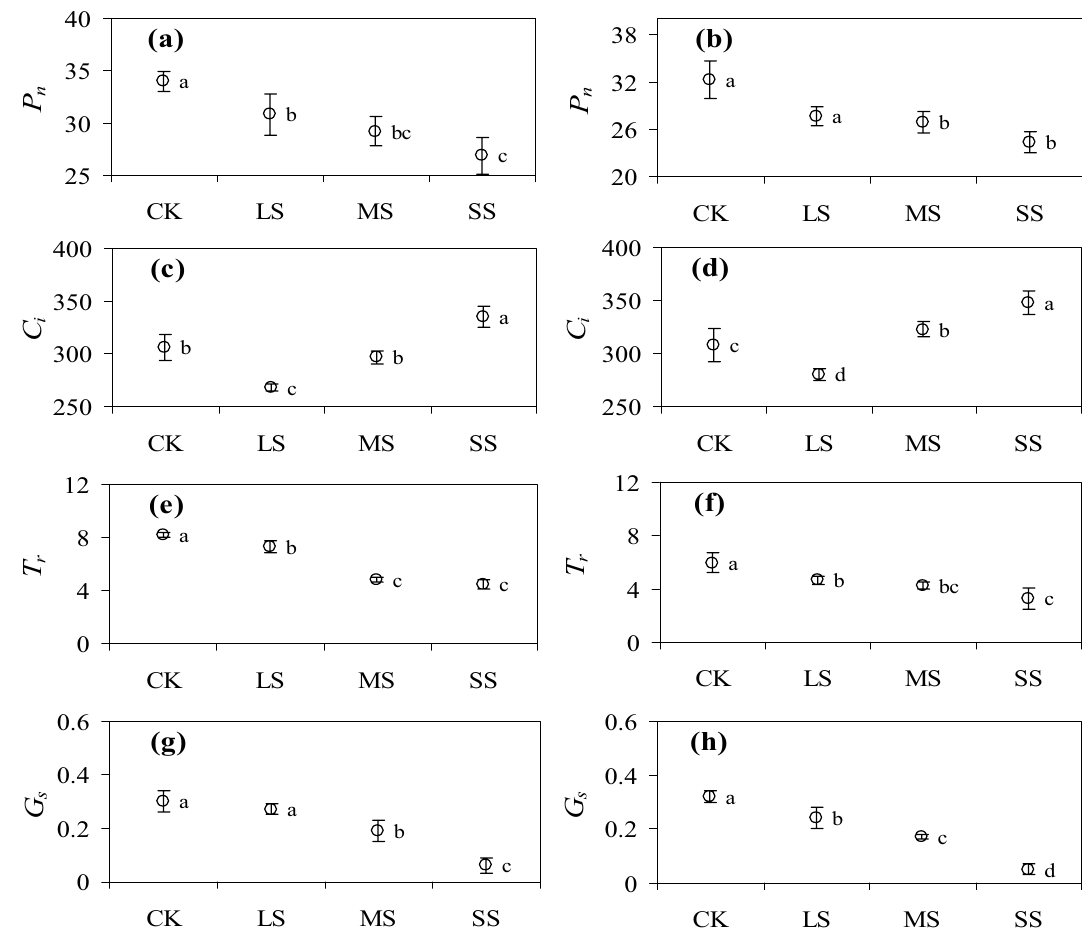
Figure 3. The photosynthetic rate ( P n , μmol m −2 s −1 ), intercellular CO 2 concentration ( C i , μmol mol −2 ), transpiration rate ( T r , mmol m −2 s −1 ) and stomatal conductance ( G s , mol m −2 s −1 ) under the control treatment (CK), low drought stress (LS), moderate drought stress (MS) and severe drought stress (SS) in 2018 and 2019. ( a , c , e and g ) represent the values in 2018, while ( b , d , f and h ) represent the values in 2019. Different letters above the columns indicate significant differences ( P < 0.05) determined by a Duncan’s test between treatments. The same letters above the error bars indicate no significant different at P >